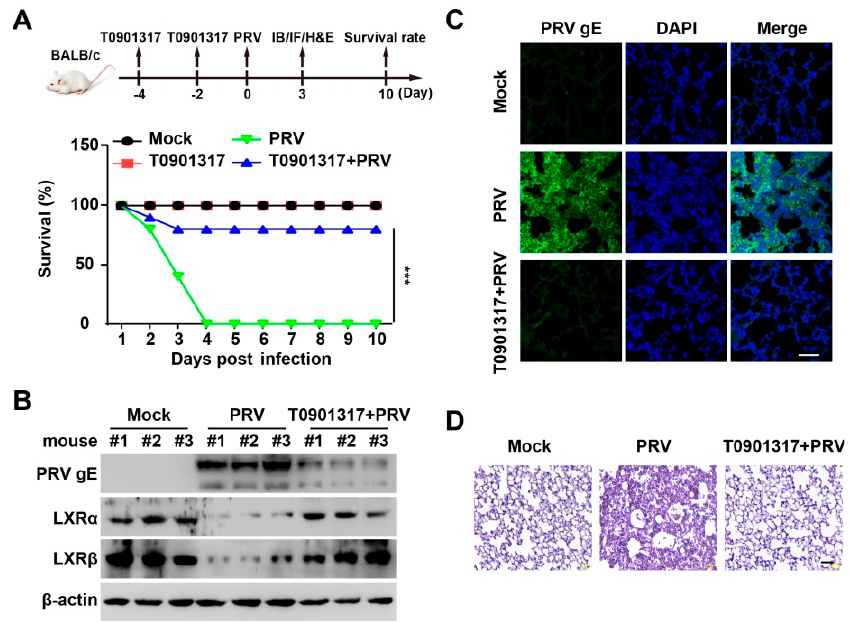
Figure 7. T0901317 inhibits PRV infection in vivo. ( A ) Mice were intraperitoneally injected with vehicle or T0901317 (30 mg/kg) on days 4 and 2. On day 0, the mice were mock infected or intranasally infected with PRV-QXX (5 × 10 3 TCID 50 /50 µ L per mouse). The survival rate was monitored daily for 10 days ( n = 12 per group). *** p < 0.001. ( B ) PRV gE, LXR α , and LXR β in the lungs were assessed by immunoblotting analysis at 3 days post-infection ( n = 3 per group). ( C ) PRV gE in the lungs was assessed by immunofluorescence at 3 days post-infection ( n = 3 per group). Scale bar: 100 µ m. ( D ) The lung injury was assessed by H&E staining at 3 days post-infection ( n = 3 per group). Scale bar: 100 μ m.